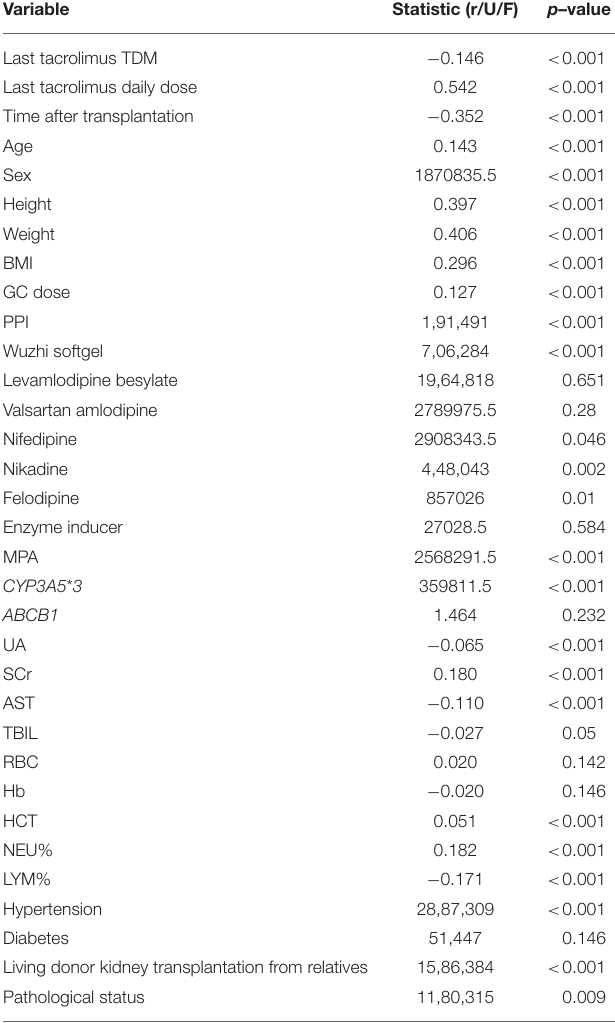
TABLE 2 | Univariate analysis